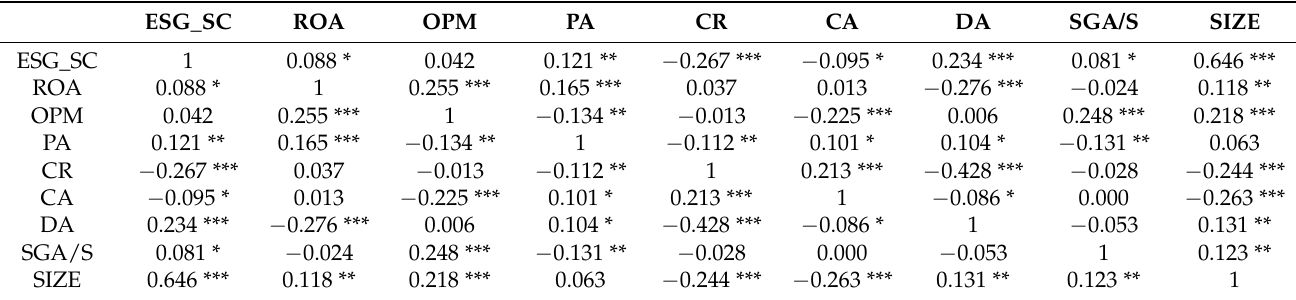
Table 4. Correlation matrix.